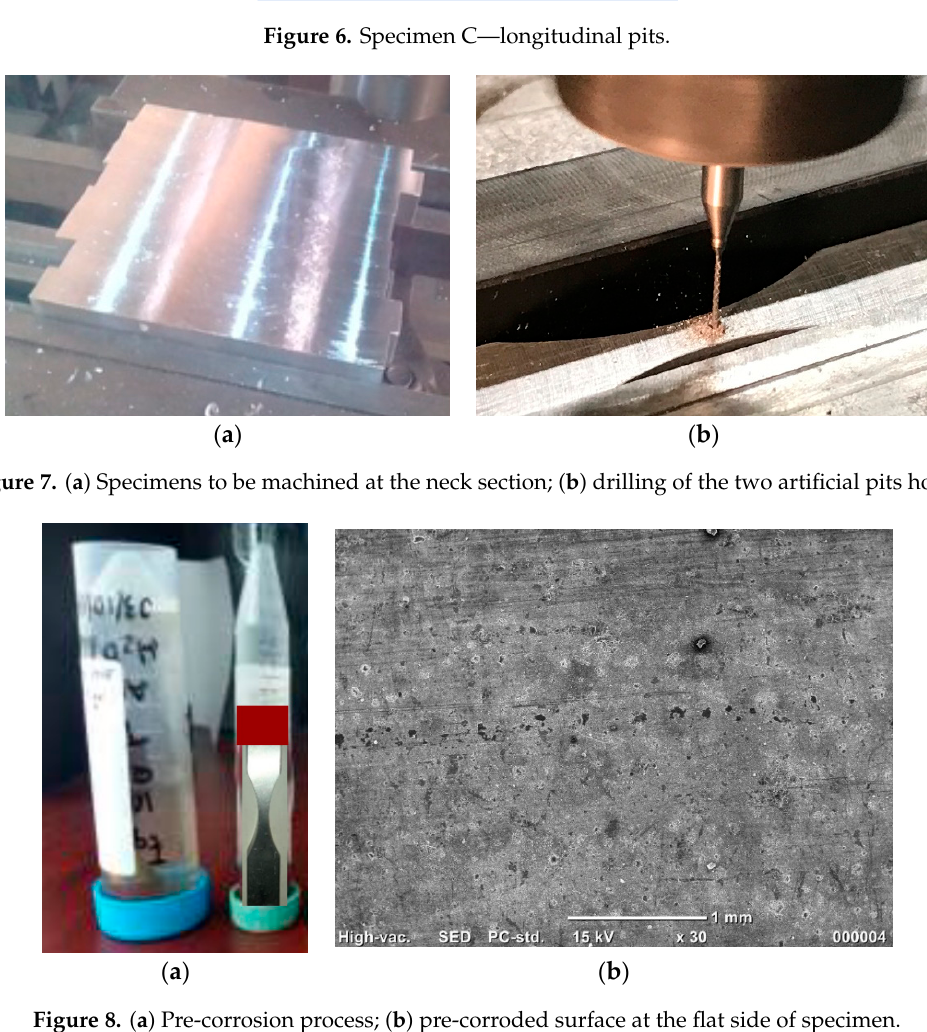
Figure 8. ( a ) Pre-corrosion process; ( b ) pre-corroded surface at the flat side of specimen.